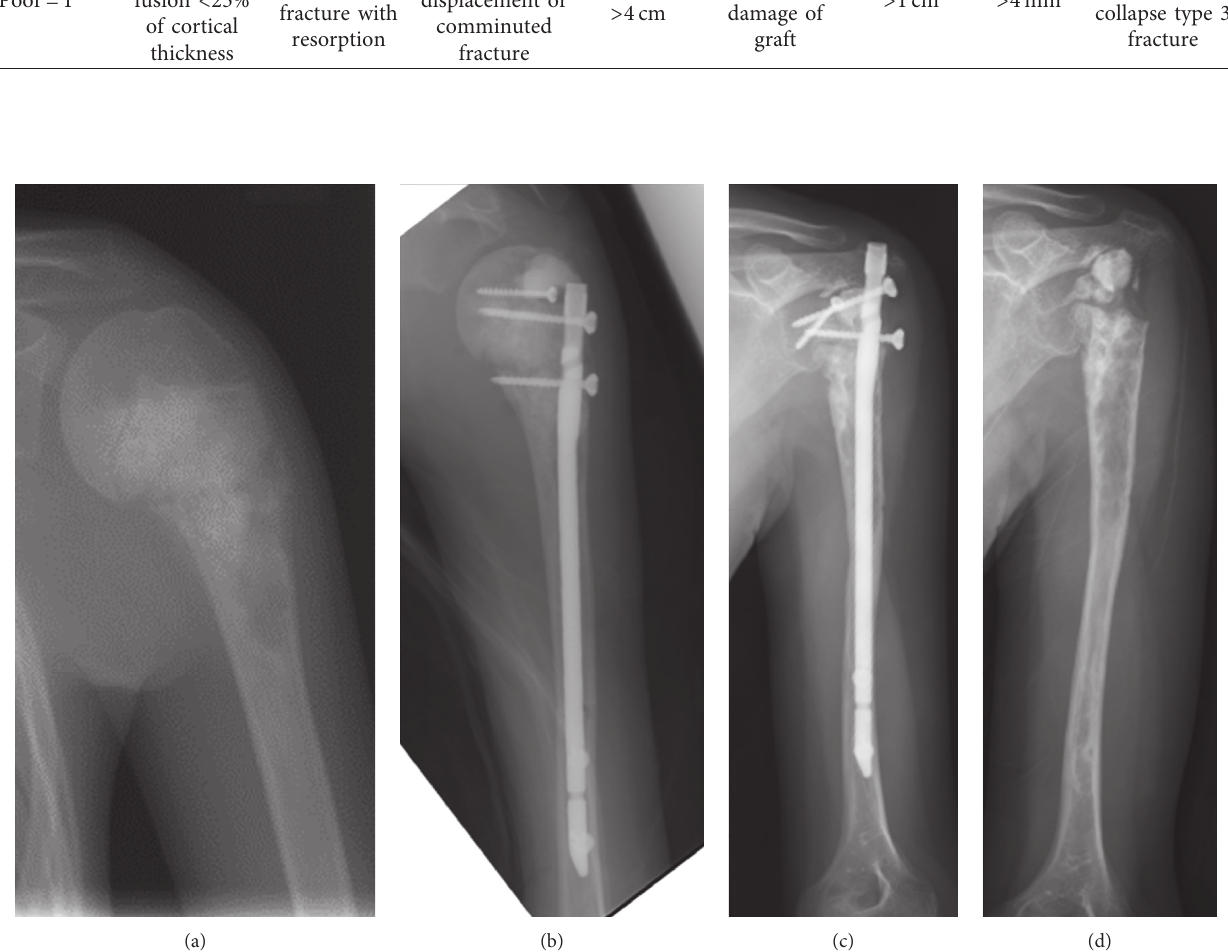
Figure 1: Case #6: 12-year-old female with osteosarcoma of the left proximal humerus. (a) Preoperative X-ray. (b) Immediately after treatment with osteoarticular extracorporeal irradiated autograft. (c) 14 years after operation, collapse of the graft and protrusion of the IM rod proceeded. (d) IM rod was